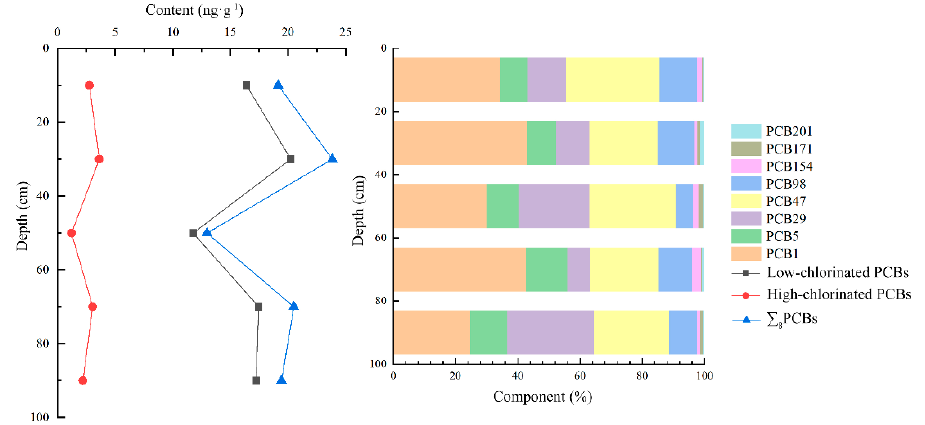
Figure 2. Concentration and component distribution of PCBs in soil profiles.